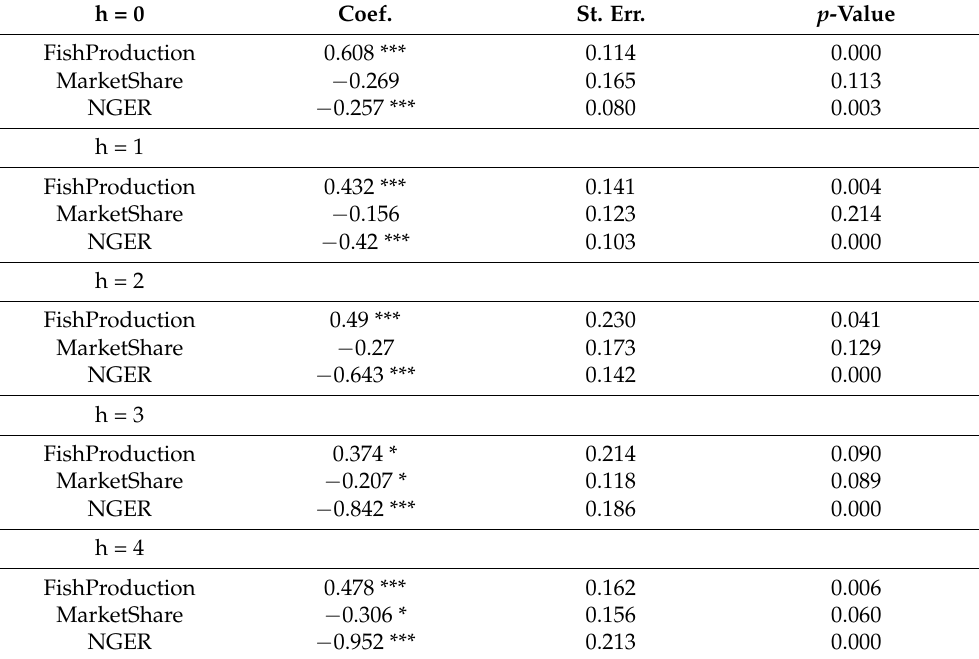
Table 4. Horizon-wise OLS Estimations.